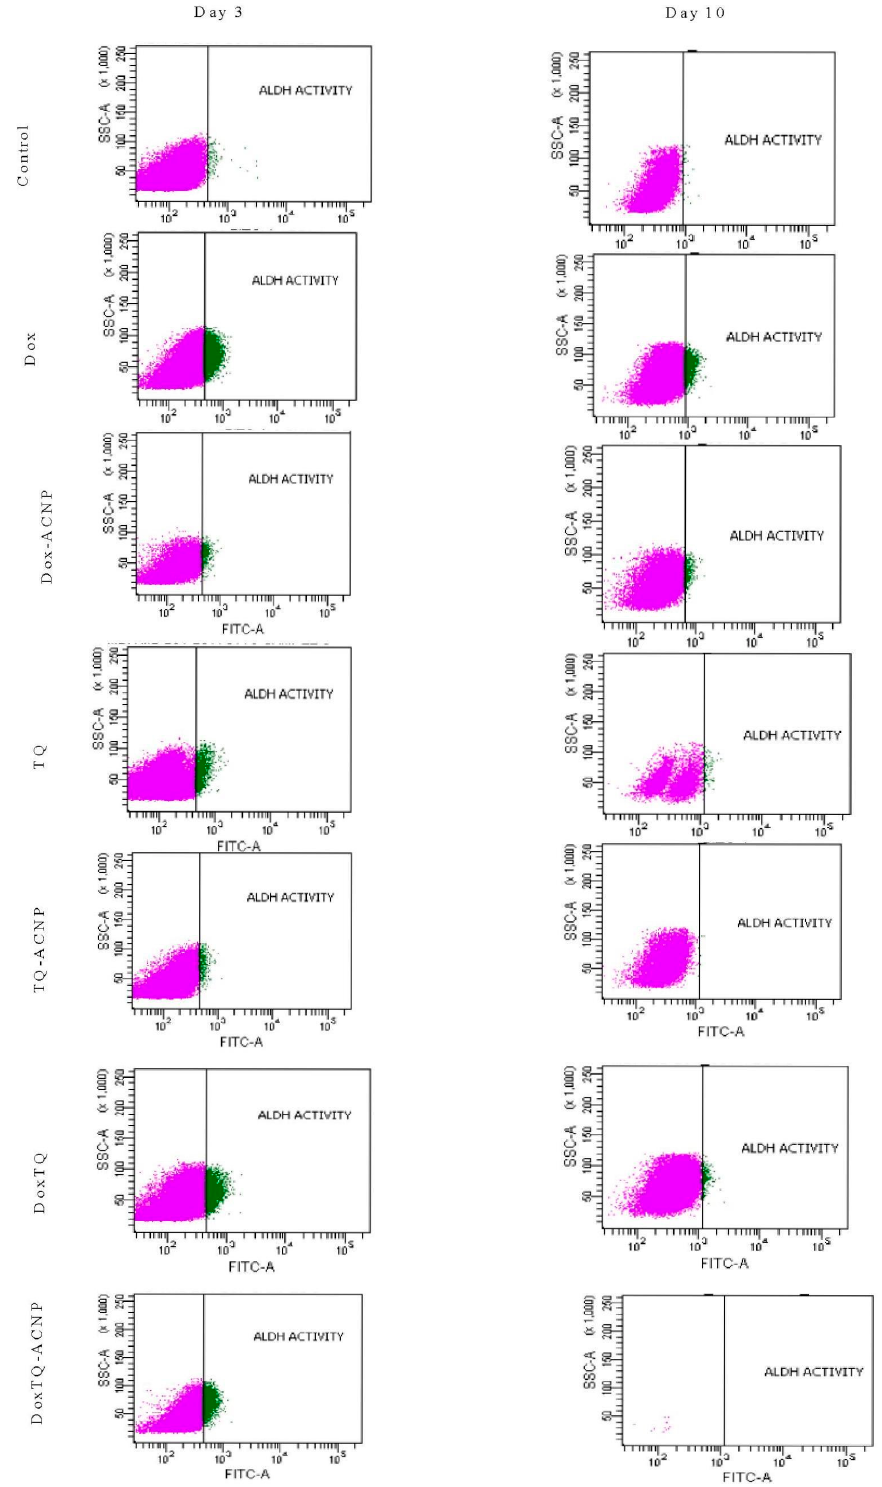
Figure 15. Flow cytometry result of ADLH activity after treatment at days 3 and 10. Purple and green indicate viable cells and ALDH activity, respectively.